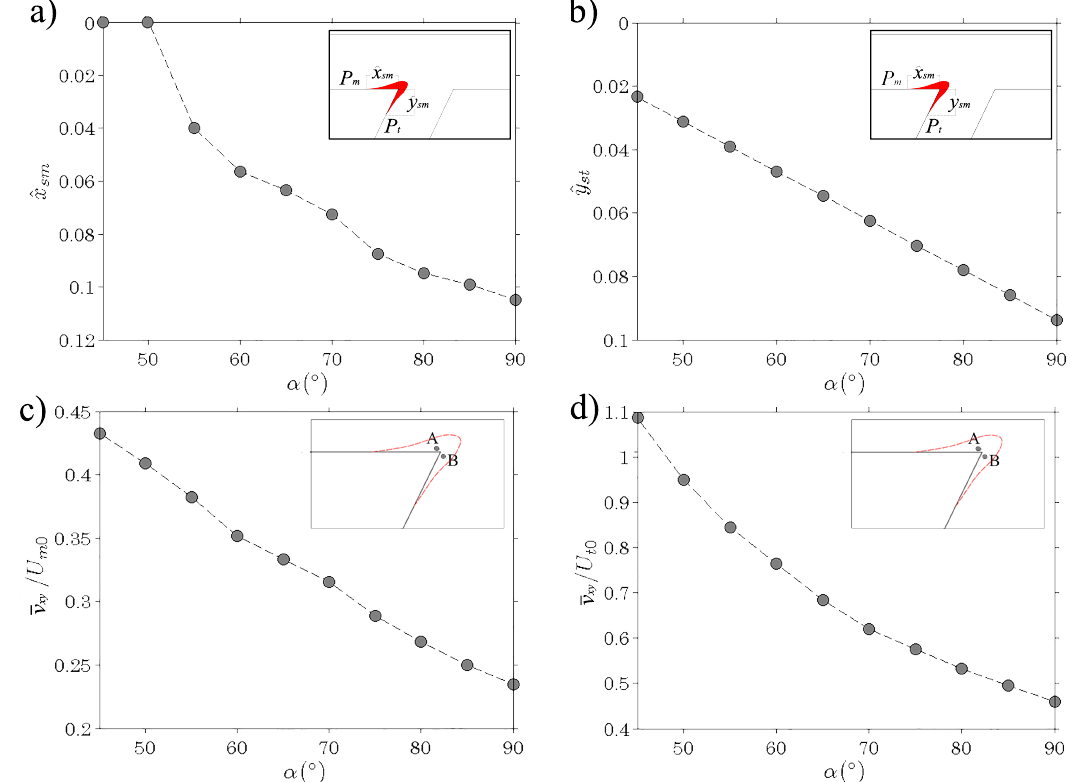
Figure 12. Distributions of ( a ) ˆ x sm and ( b ) ˆ y st with respect to α at ˆ z ∼ 0.5 and of the relative flow velocity at points ( c ) A and ( d ) B within the retardation zone with respect to α at ˆ z ∼ 0.5.